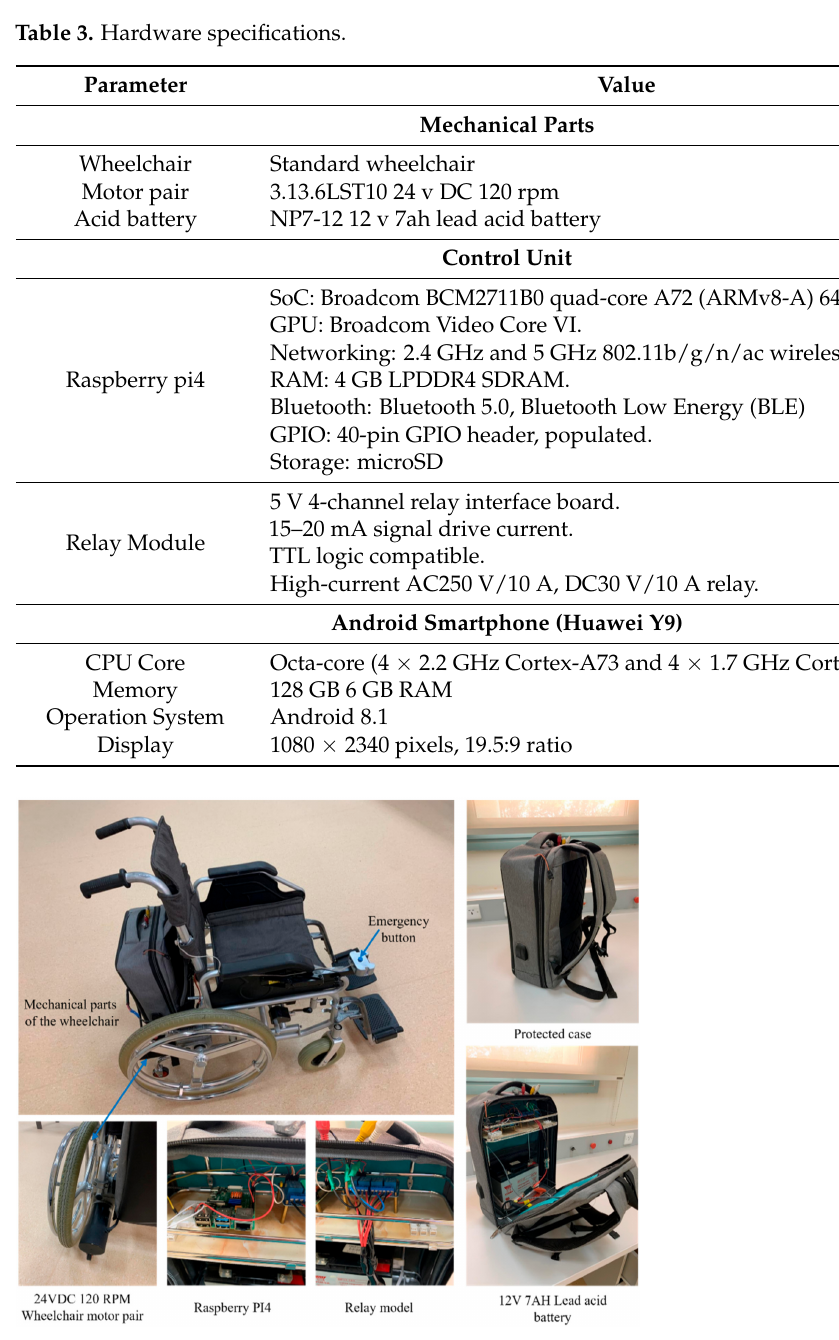
Figure 3. Mechanical assembly of wheel